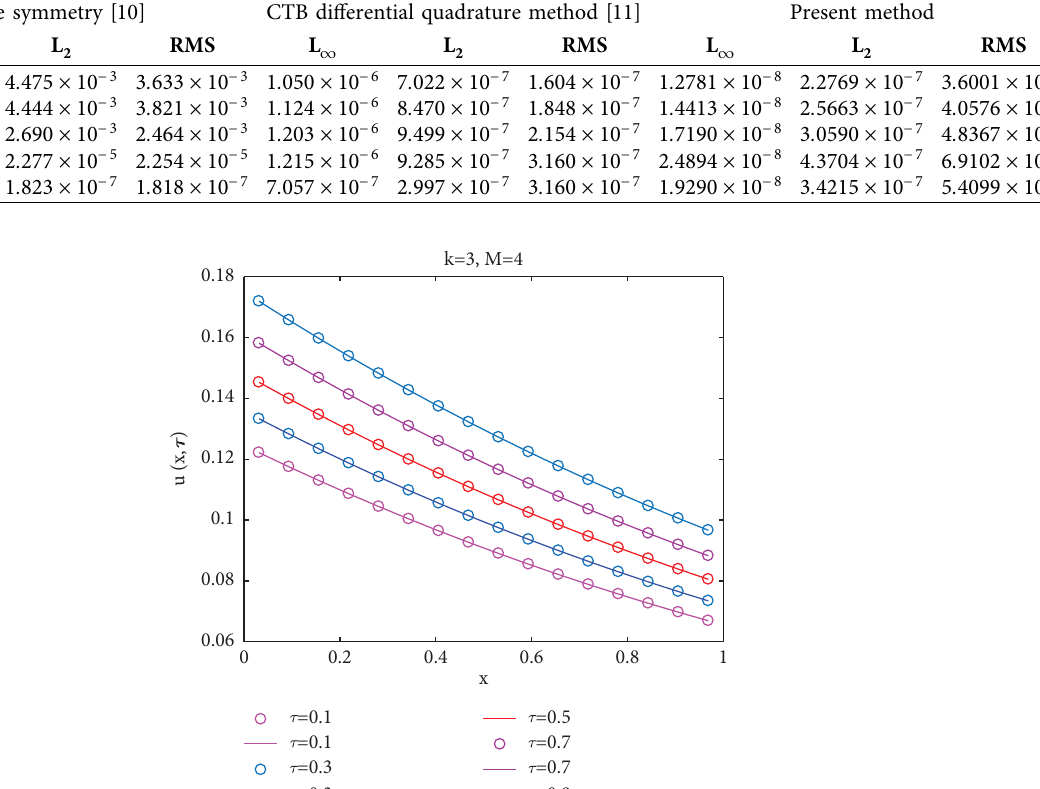
, L , and RMS error norms of present method with [10, 11] for Example 1 at diferent τ . ∞ 2